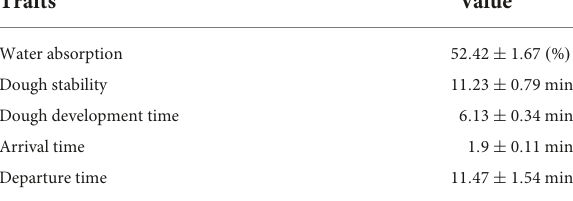
TABLE 11 Mean values for farinographic studies of wheat flour purchased from Faisalabad market.